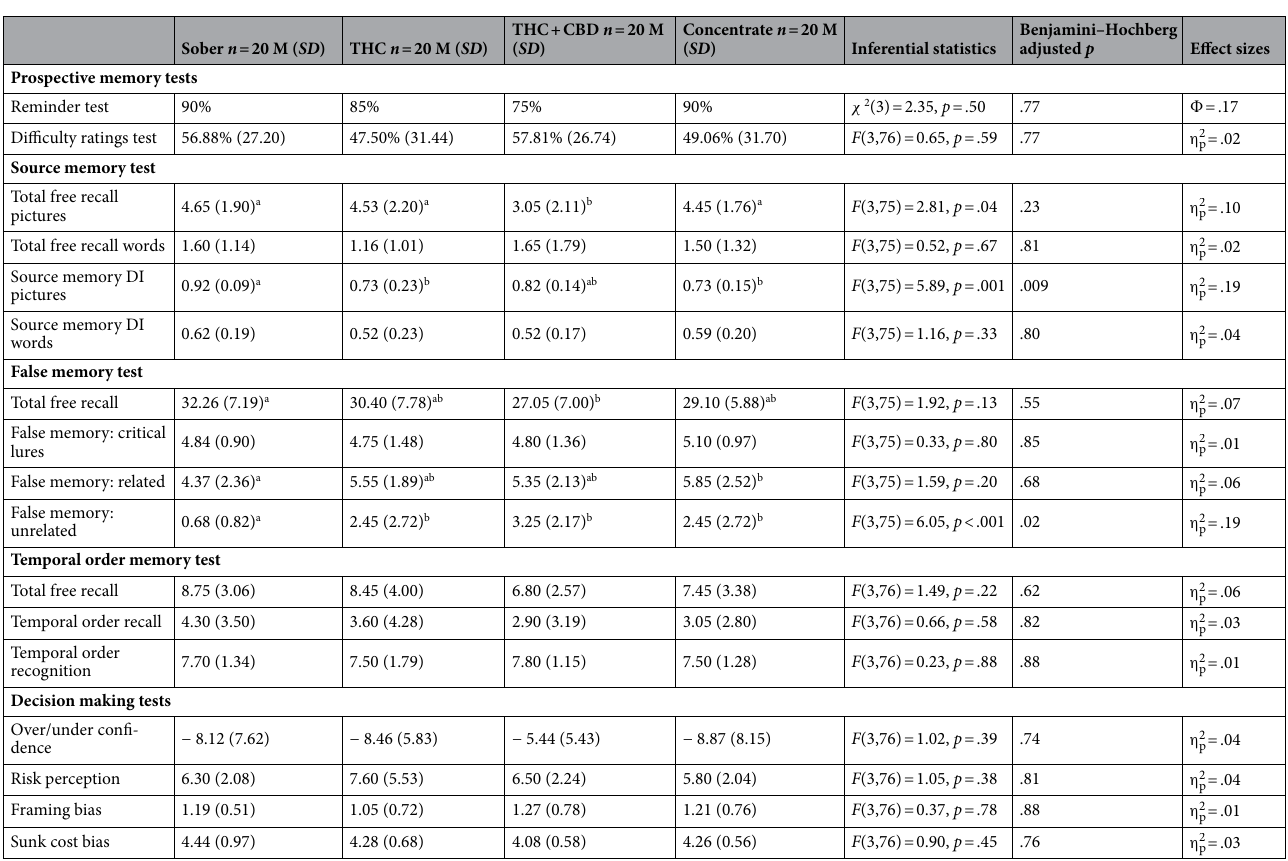
Table 2. Cognitive test performance. Values in Reminder Test row reflect the % of participants in each group who succeeded on the test while those in the Difficulties Rating Test row reflect the mean % of tests for which a difficulty rating was provided. Means with no superscripts or shared superscripts do not differ significantly while those with different superscripts are significantly different at p < .05. η 2 p = .01 is small, η 2 p = .06 is medium, η 2 p = .14 is